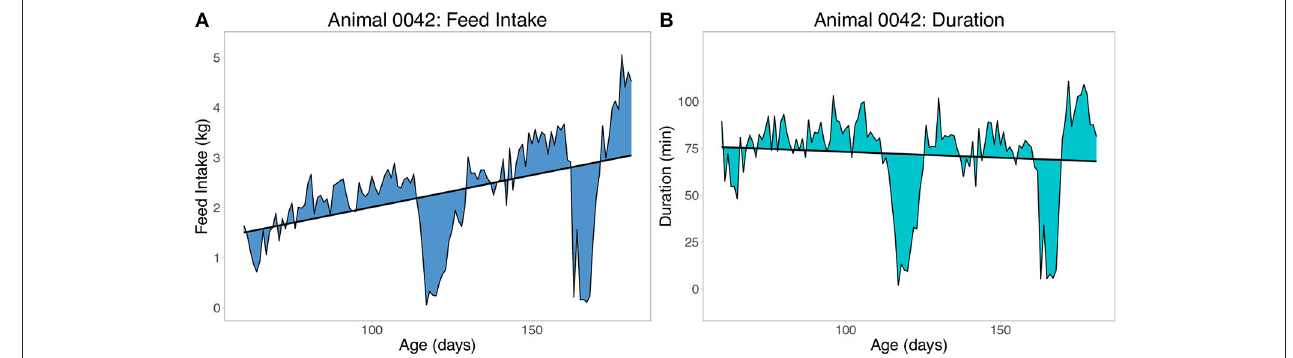
FIGURE 3 | Example of the root mean square error (RMSE) of feed intake (A) and feeding duration (B) as measures of resilience. Duration is time spent at the feeder in minutes. Each animal received one record from a within animal regression of feed intake or duration on